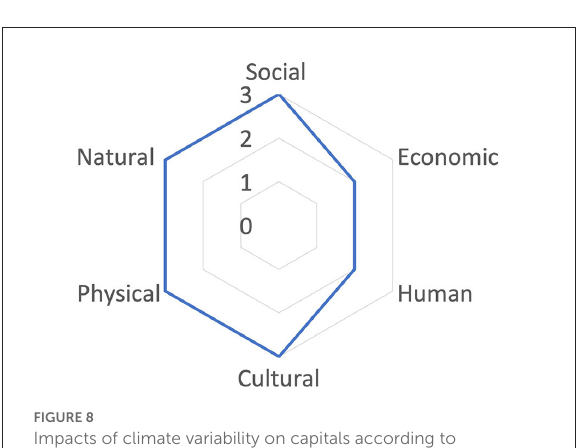
FIGURE8 Impacts of climate variability on capitals according to households’ perception. Impacts range from 0 to 3 (0 is the lowest and 3 the